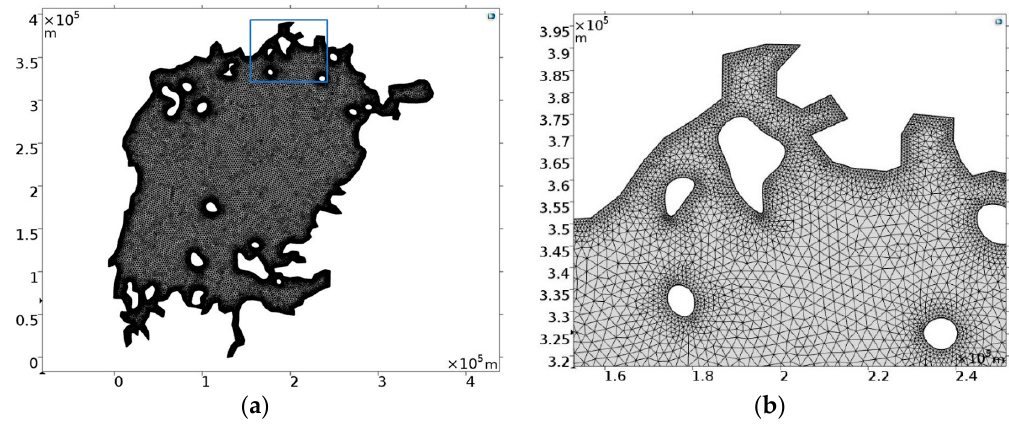
Figure 8. Finite element mesh in COMSOL: ( a ) Whole lake; ( b ) zoom of the outflow region.